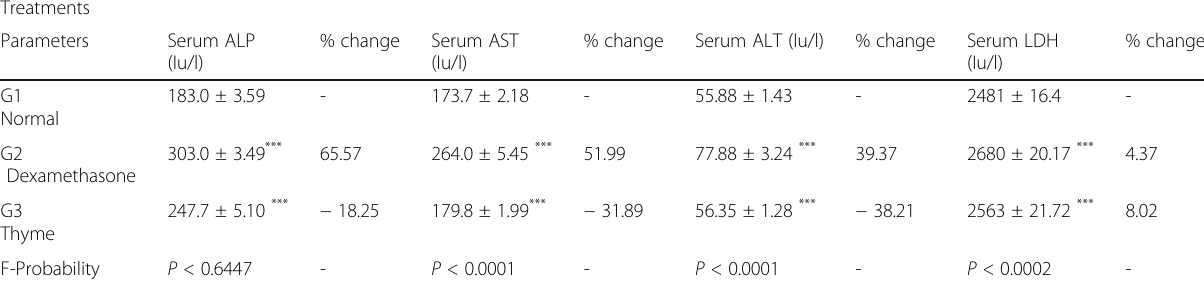
Table 1 The defensive role of thyme aqueous extract on serum alkaline phosphatase (ALP), aspartate aminotransferase (AST), alanine aminotransferase (ALT), and lactate dehydrogenase (LDH) activities in normal and dexamethasone (DXM) treated rats Treatments